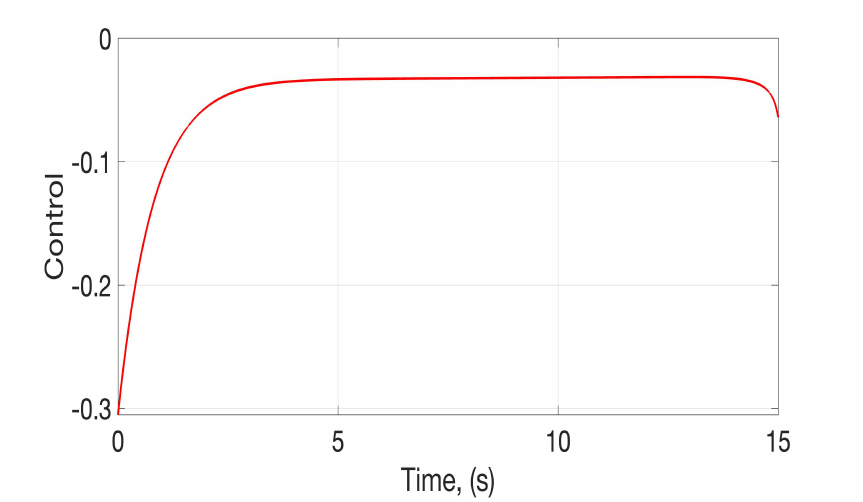
Figure 4. Temporal evolution of the control action u ∗ evaluated with the application of the approxi- mate model based on the DNN.